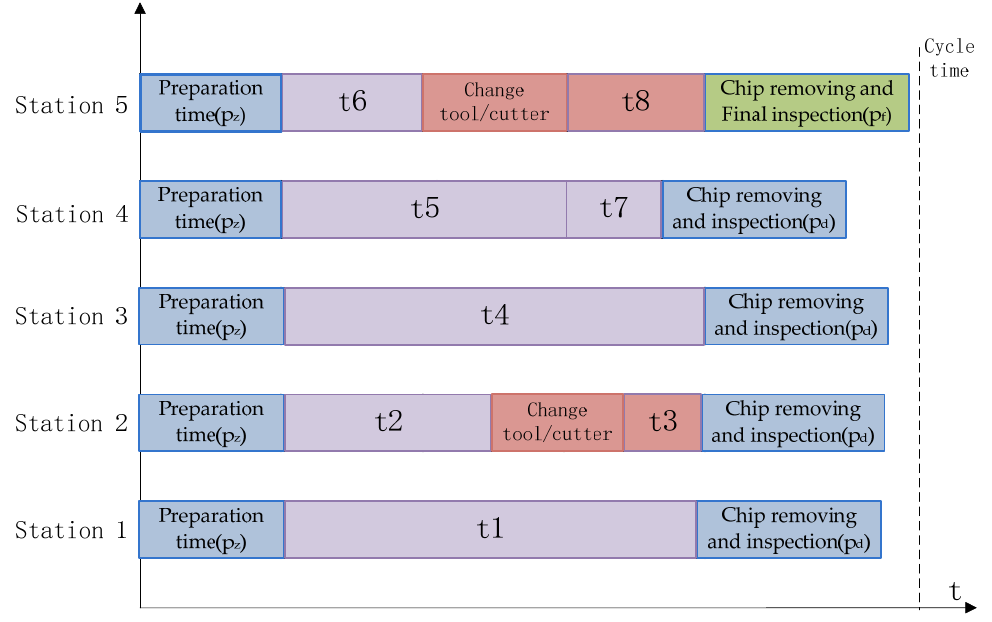
Figure 4. Gantt diagram of 5-station process layout satisfying the constraints of Figures 2 and 3.